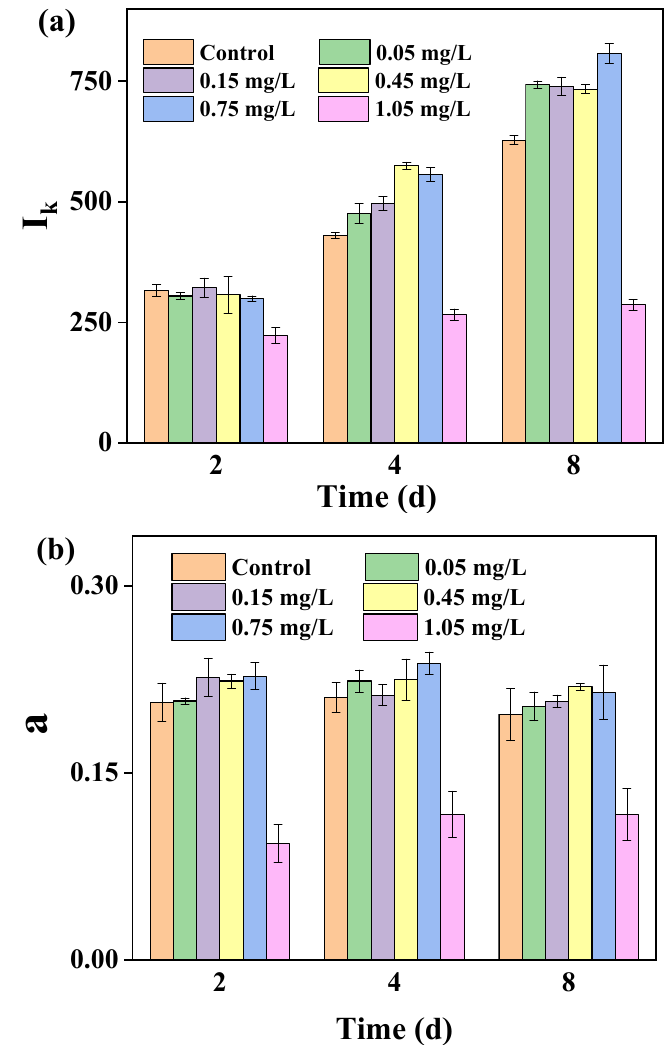
Figure 5. Effects of triclosan on the Ik ( a ) and α ( b ) values of Chlorella vulgaris .